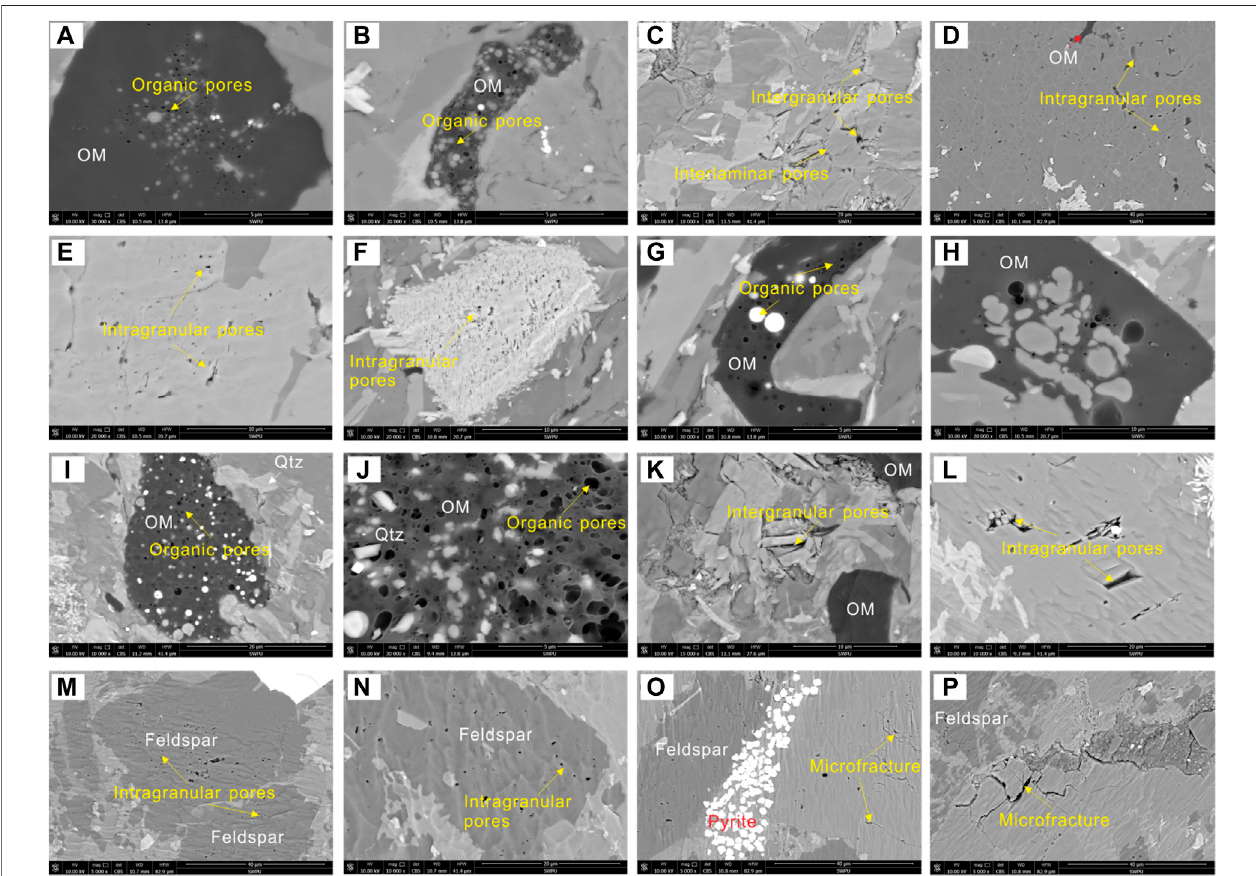
FIGURE5| High-resolutionSEMimageofUpper PermianLinghao Formation shale/mudstone. (A,B) Organicpores inasingleOMgrainoforganic-richshale,Ling 1member,3,772.40 m. (C,D) Organic-richshale,Ling1member,3,770.30 m (E) Intragranularporesofdissolutionorigininmudstone,Ling2member,3,556.80 m. (F) Intragranular pores of dissolution origin in mudstone, Ling 2 member, 3,558.48 m. (G) Mudstone, Ling 2 member, 3,558.48 m. (H) Mudstone, Ling 2 member, 3,556.80 m. (I,J) Abundantorganicporesinorganicmatter – inorganicmineralcomplexoforganic-richshale,Ling3member,3,407.00 m. (K,L) Organic-richshale, Ling 3 member, 3,407.00 m. (M,N) Intragranular pores of dissolution origin in feldspar grain, shale, Ling 3 member, 3,261.82 m. (O,P) Microfractures in clay mineral, shale, Ling 3 member, 3,261.82 m